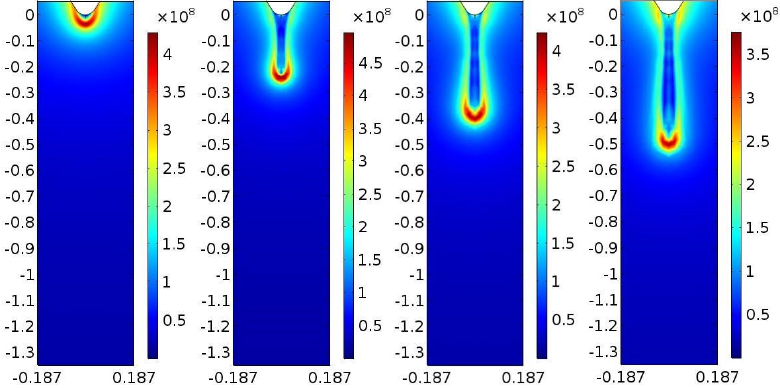
Figure 5. Positive streamer propagation. Evolution of the electric field ( V/m ) in nanofluids with τ np = 50 ns along the z -axis, applying 300 kV and with a rise time of 10